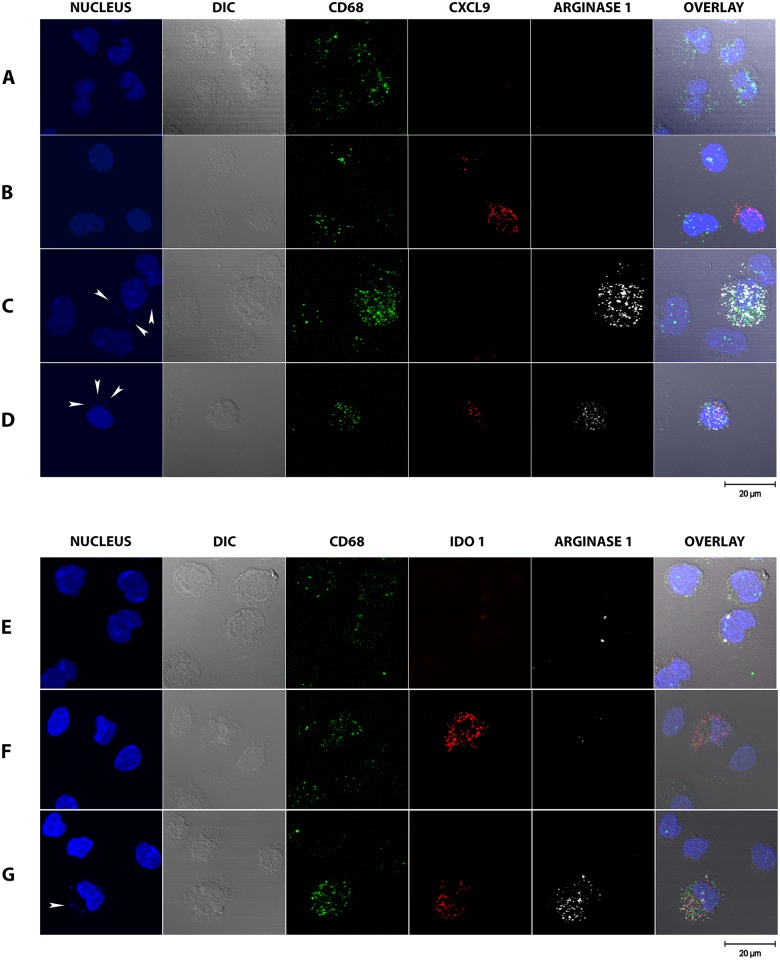
Single-cell expression of Cxcl9, Arg1, and Ido1 RNAs in splenic macrophages from uninfected and L. donovani infected hamsters.The single-cell expression of M1-associated (Ido1 and Cxcl9) and M2-associated (Arg1) mRNA transcripts and CD68 in splenic macrophages from uninfected (row A) and L. donovani infected hamsters (rows B, C, and D) was determined by in situ amplification and fluorescence hybridization. To determine co-expression, cells were hybridized with fluorescent probes specific to CD68, CXCL9, and Arginase 1 (upper panel) or CD68, IDO1, and Arginase 1 (lower panel) and imaged using confocal microscopy. Nuclei were detected by DAPI staining and cellular morphology by Differential interference contrast (DIC) microscopy. In some cases, parasite nuclei could be seen adjacent to macrophage nuclei (indicated by white arrowheads in the DAPI stained cells). The percent of single-positive and double-positive cells was calculated by counting 100 CD68-positive cells. Uninfected cells (row A) were negative for CXCL9, IDO1, and Arginase 1.